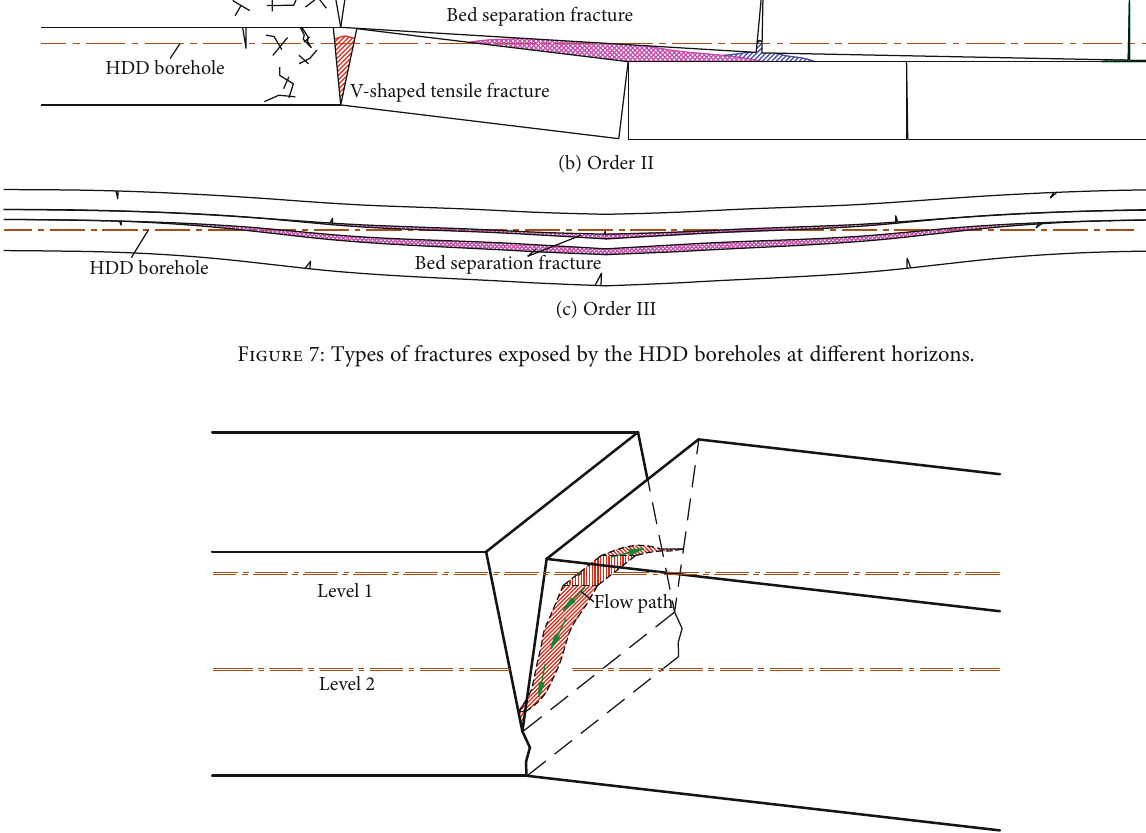
Figure 8: Schematic diagram of grouting the V-shaped tensile fractures exposed by